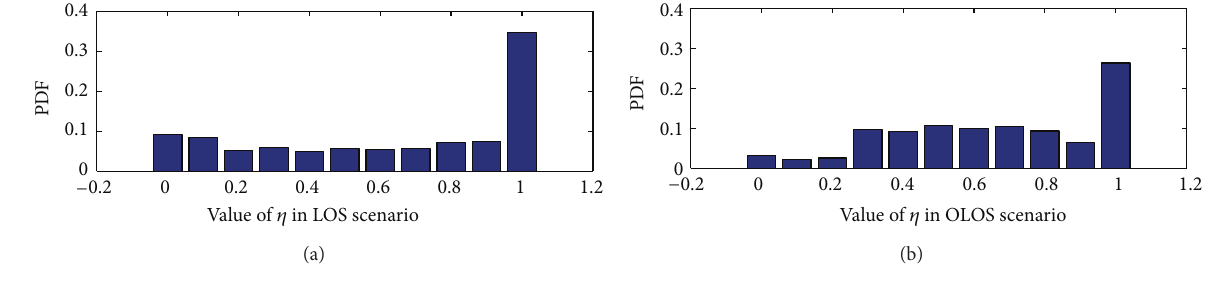
Figure 11: Statistical characteristic of